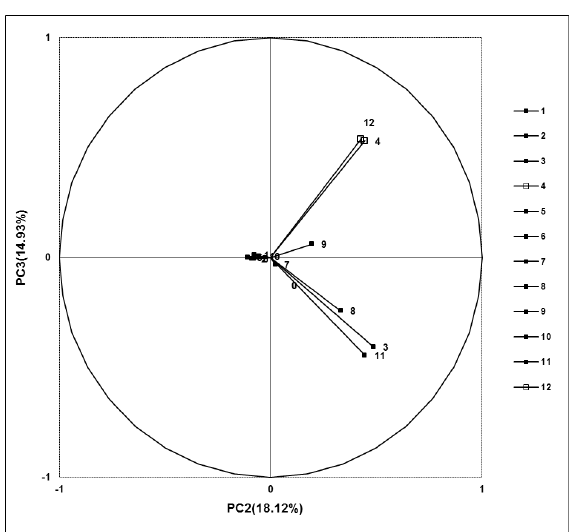
Figure 3: PCA graph for all samples. Numbering as in Table